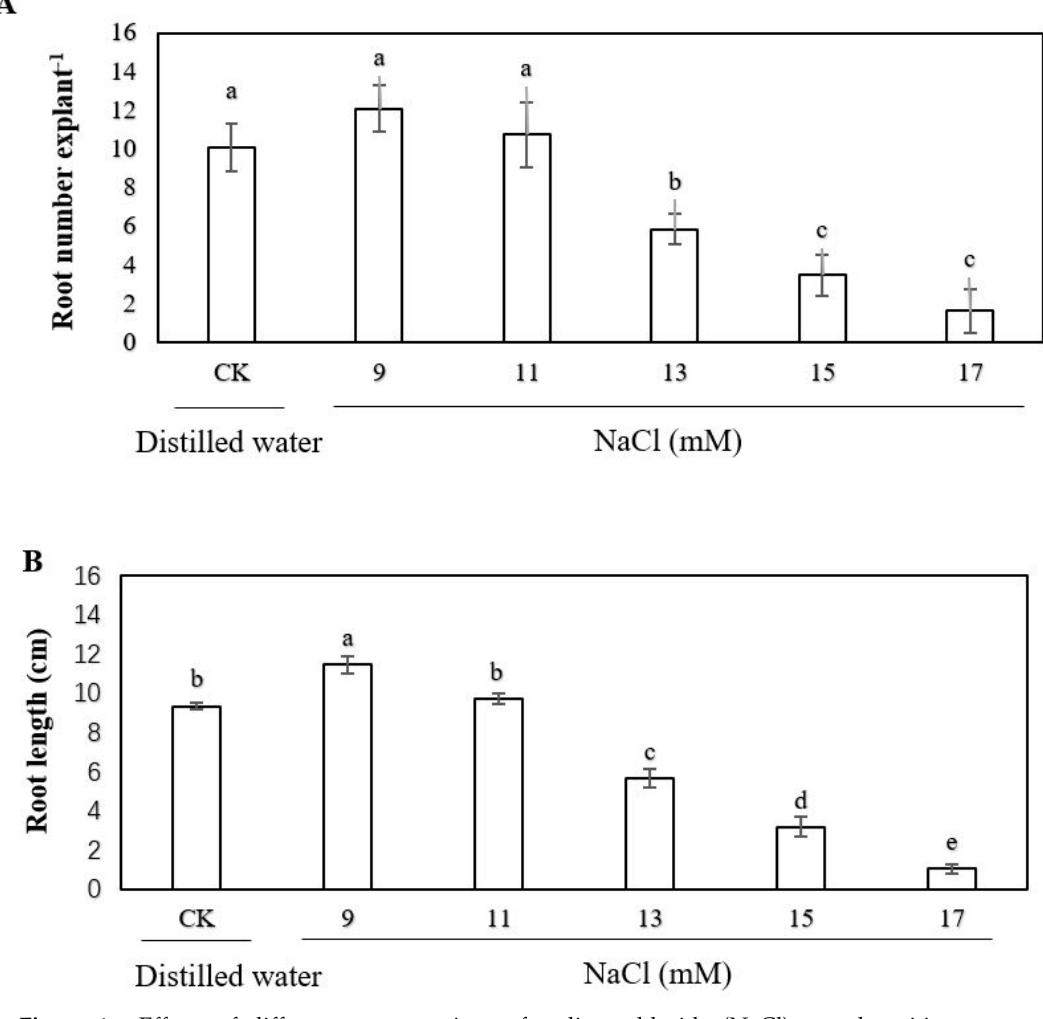
Figure 1. Effects of different concentrations of sodium chloride (NaCl) on adventitious root development in cucumber explants. The primary roots were removed from hypocotyl of five-day-old seedlings. The explants were incubated for three days with different concentration of NaCl after two days of distilled water culture. The numbers (A) and root length (B) of adventitious root were expressed as mean ± SE (n = 3, 10 explants were used per replicate). Bars with different lowercase letters were significantly different by Duncan’s multiple range test ( P < 0.05).